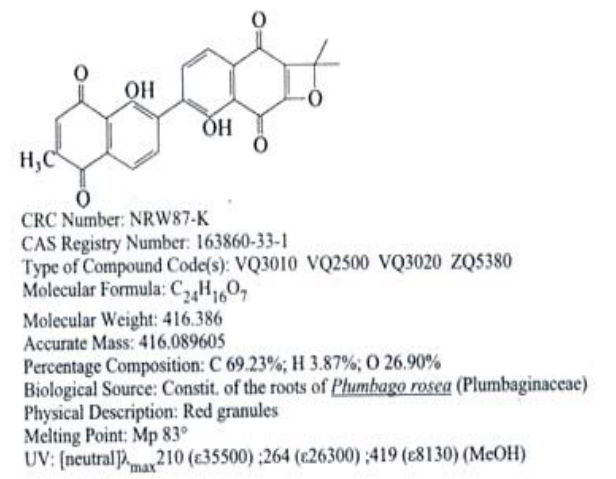
Figure 4. Molecular structure of Roseanone (C